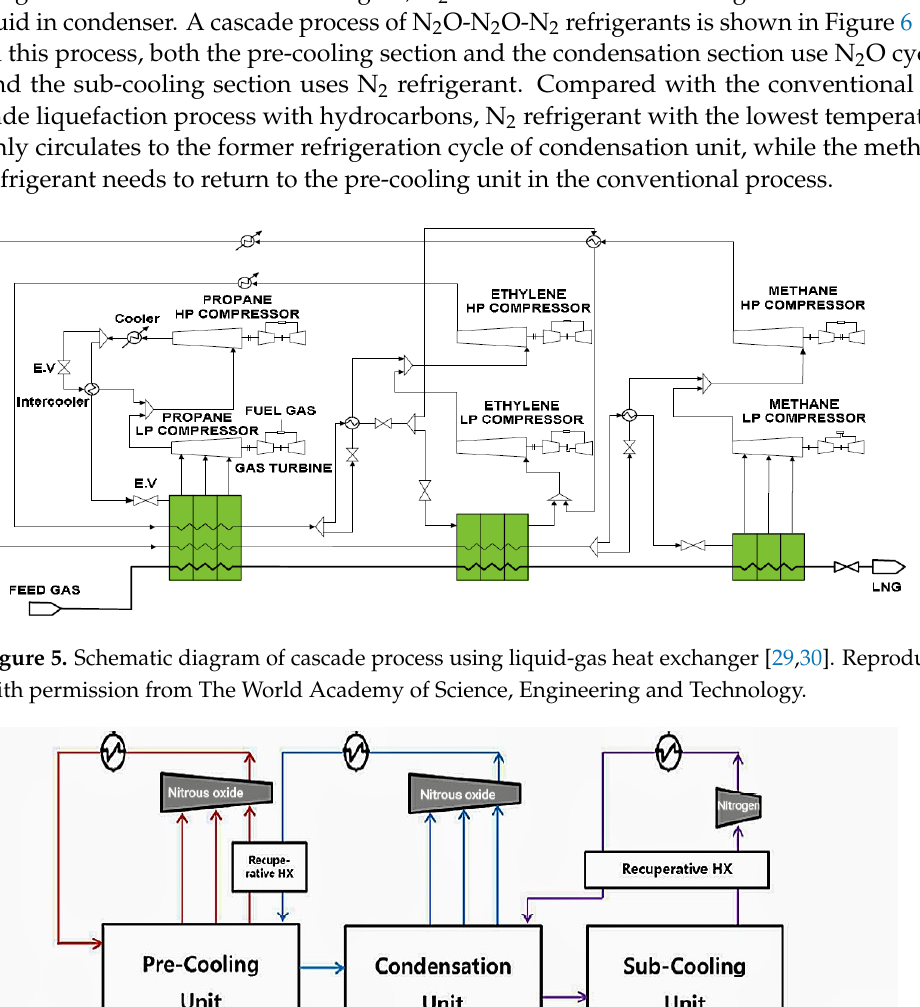
Figure 6. The proposed N 2 O-N 2 O-N 2 cycle for natural gas liquefaction [37].